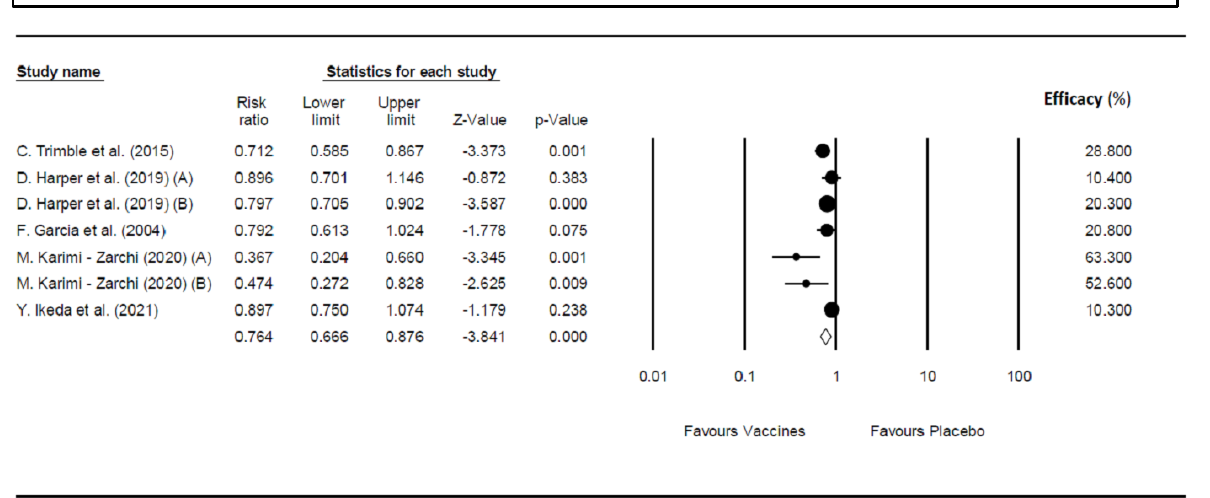
Figure 5. Forest plot of vaccines’ efficacy against high-grade cervical intraepithelial neoplasia (CIN 2/3) in women compared with placebo. Data were obtained by the presence of CIN 2/3 confirmed cases in vaccinated group versus unvaccinated group [35–37,39,41].